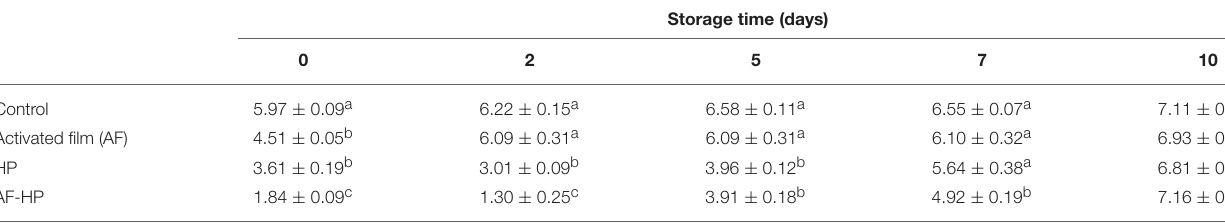
TABLE 1 | Viable cell counts for total aerobic mesophiles in sea bream fillets stored under refrigeration.